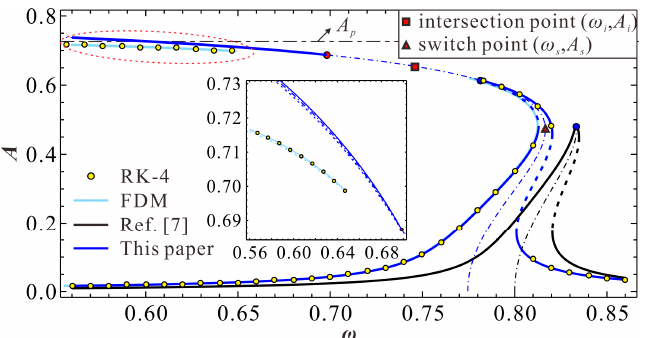
Figure 5. Bending motion of the primary frequency response for α = 1.5, γ = 0.1, µ = 0.005, δ = 100 and ρ = 9 × 10 − 5 (note that ρ i = 1.22 × 10 − 4 and ρ s = 9.62 × 10 − 5 ; solid line: stable solutions; dashed line: unstable solutions).